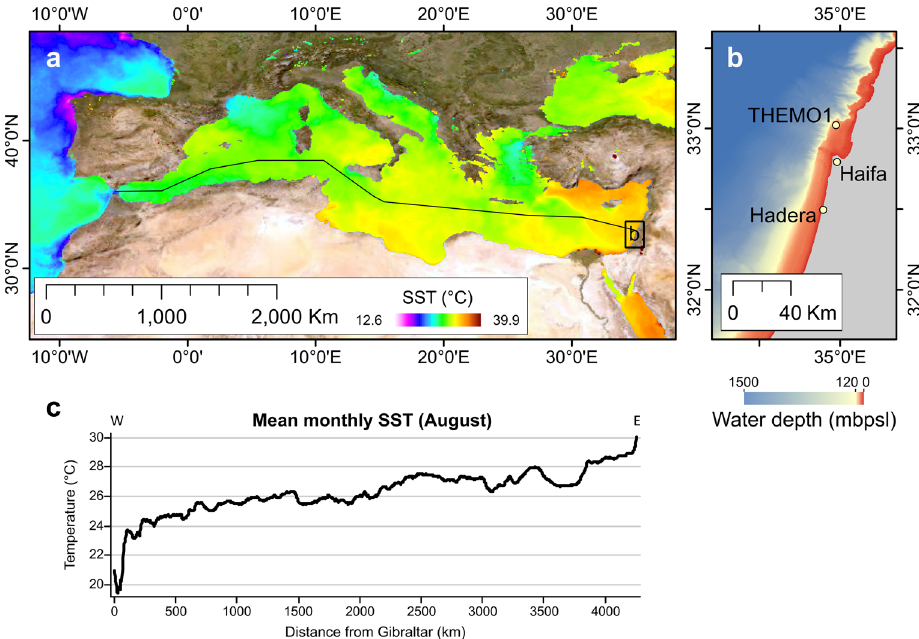
Figure 1. ( a ) Location map of the Mediterranean Sea showing sea surface temperature (SST) in °C for August 2016, Data from MODIS|Aqua (https:// ocean color. gsfc. nasa. gov/). ( b ) bathymetric map of the Israeli shelf 24 showing the location of the Hadera and THEMO1 stations. ( c ) SST temperature prolife along the transect shown in ( a